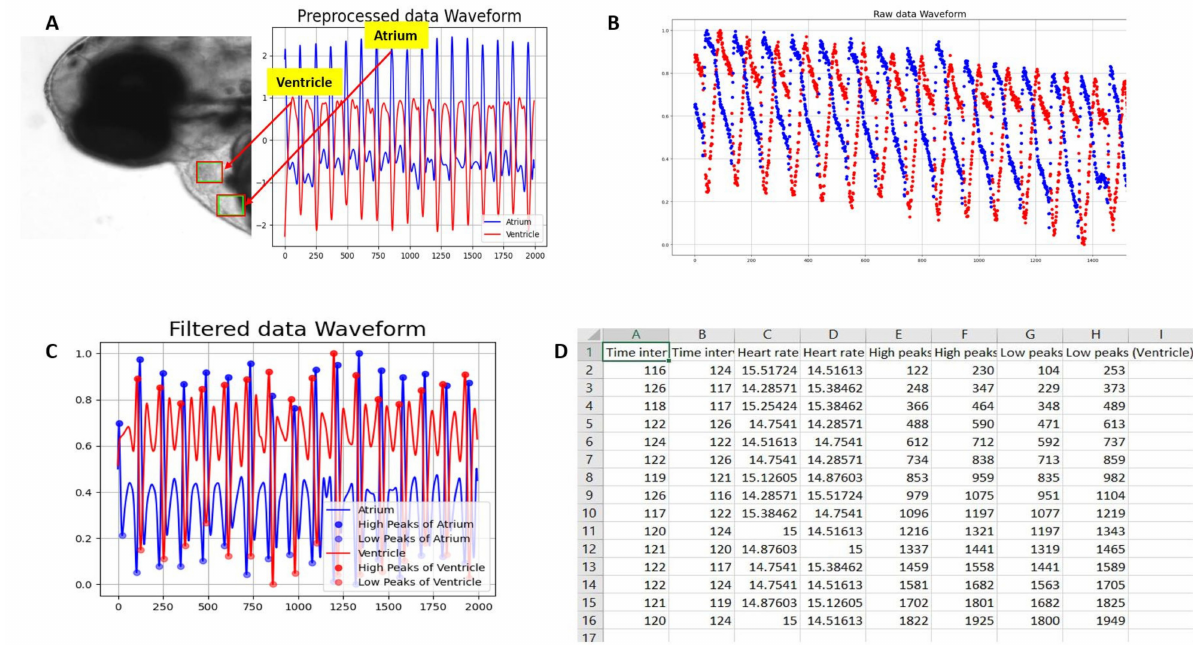
Figure 2. ( A ) ROI selection for ventricle and atrium in zebrafish heart video. The amplitude on the y-axis and the number of frames on the x-axis against the ROI in the selected video were presented. The division algorithm was to find the peaks based on each frequency of selected frames. ( B ) Raw heartbeat signals obtained from OpenCV. Blue peaks showing atrium heart rate, and red peaks presented ventricle heart rate. The X-axis contains the number of frames, and the y-axis shown amplitude based on pixels intensity. Overlay graph having atrium and ventricle beat per minute results. ( C ) The filtered heartbeat waveforms for both the atrium (blue color) and ventricle (red color). ( D ) Output data format in excel showing some important